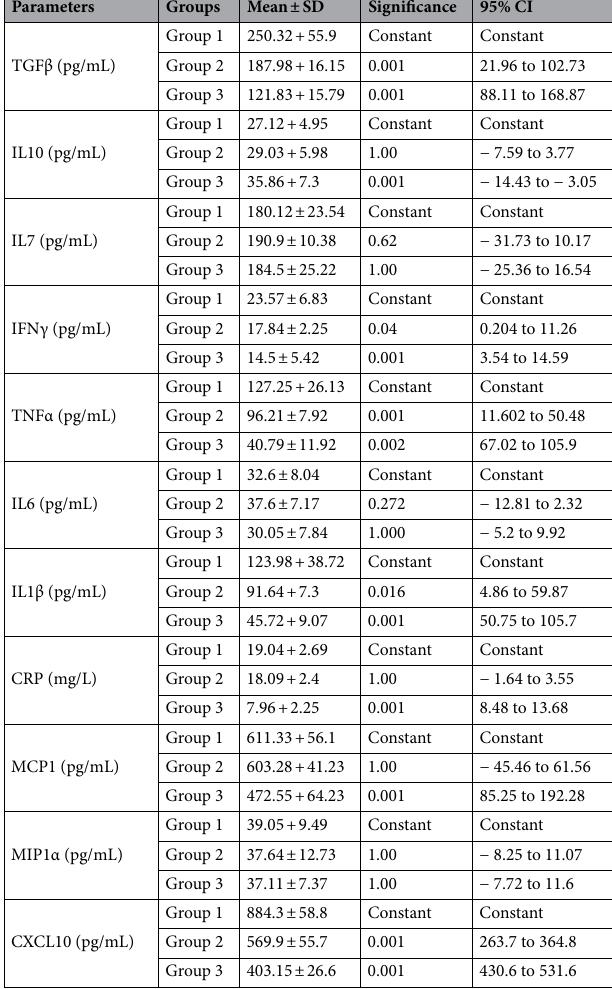
organ gastro-enteric disease (N = 11) were chosen as the target population for analysis. The analysis revealed that out of all the selected parameters tested; five parameters, HCMV viral load, TGFβ, TNFα, IL1β and CXCL10 could only significantly predict the prevalence of HCMV induced end organ retinitis among group 1 patients. The mean concentrations for HCMV viral load, TNFα and IL1β were significantly reduced in case of patients with end organ retinitis (HR), whereas the mean concentrations of TGFβ and CXCL10 were significantly higher in case of patients with retinitis. A detailed analysis has been provided in Table 3. Determination of cut‑off values for significant parameters in predicting HCMV induced end organ retinitis. Receiver-operating characteristic (ROC) curves of the selected models were derived for all the chosen critical biomarkers. The curves were used to evaluate the individual cut-off values prioritizing both highest sensitivity and specificity. Of the 5 predictive biomarkers, namely HCMV viral load, TGFβ, TNFα, IL1β and CXCL10 associated with HCMV induced end organ retinitis or gastro enteric disease in univariate models, only TGFβ and CXCL10 (IP10) demonstrated best accuracy as single biomarkers (AUC 0.900 [95% CI 0.766–1.00] and AUC 0.865 [95% CI 0.707–1.00] respectively). None of the other factors showed good predictive powers for determination. Receiver operating characteristic (ROC) curve for HCMV viral load was found to